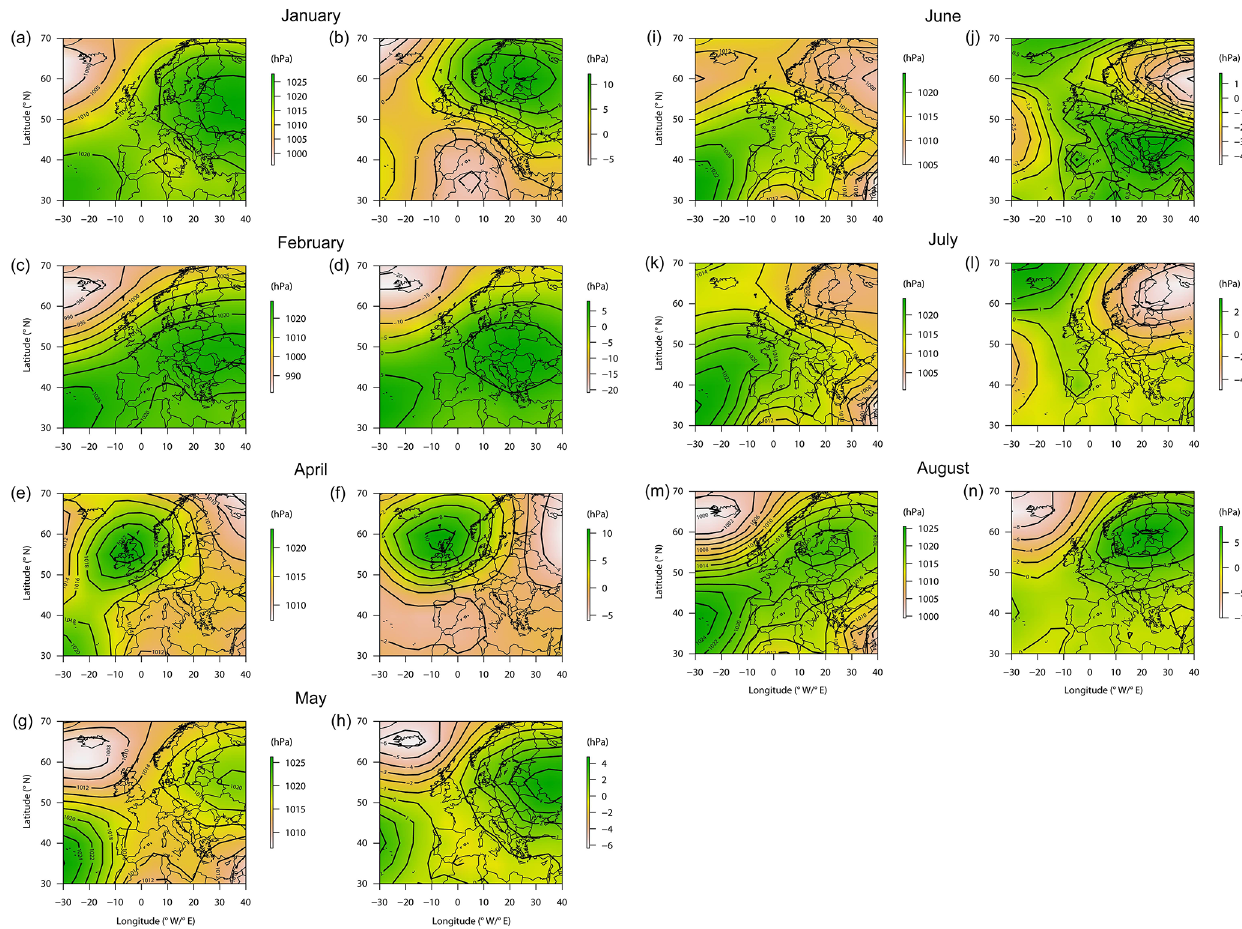
Figure 7. Mean sea-level pressure and deviations with respect to the reference (1961–1990) period means in the European-Atlantic area for the months of January (a, b) , February (c, d) , April (e, f) , May (g, h) , June (i, j) , July (k, l) , and August (m, n)